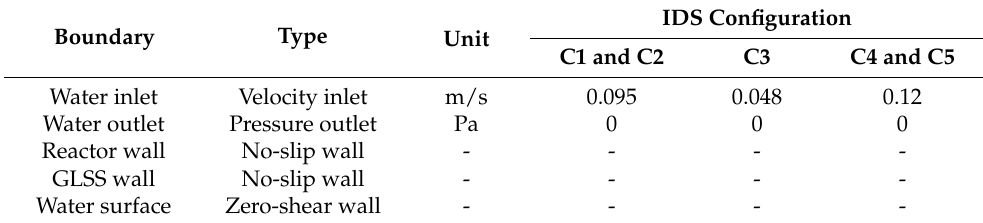
Table 2. CFD boundary